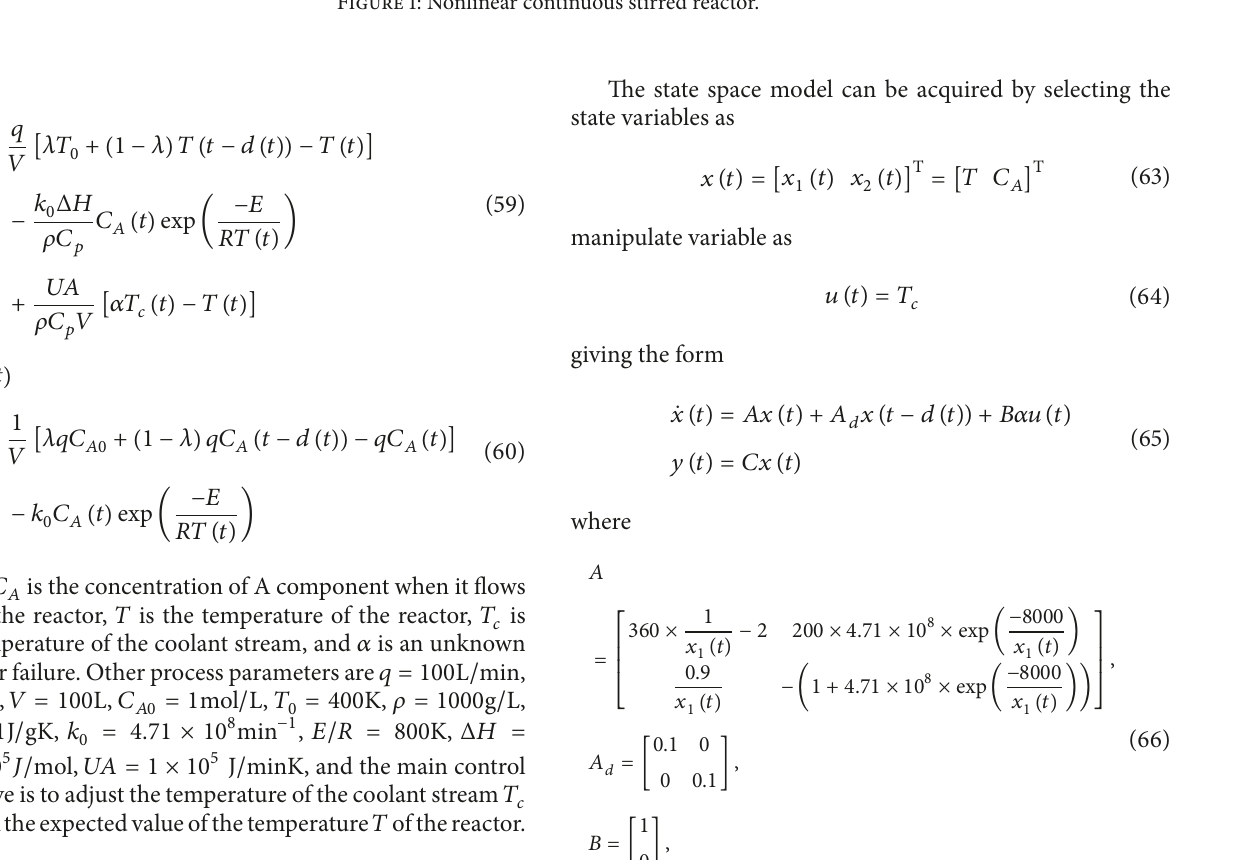
Figure 1: Nonlinear continuous stirred